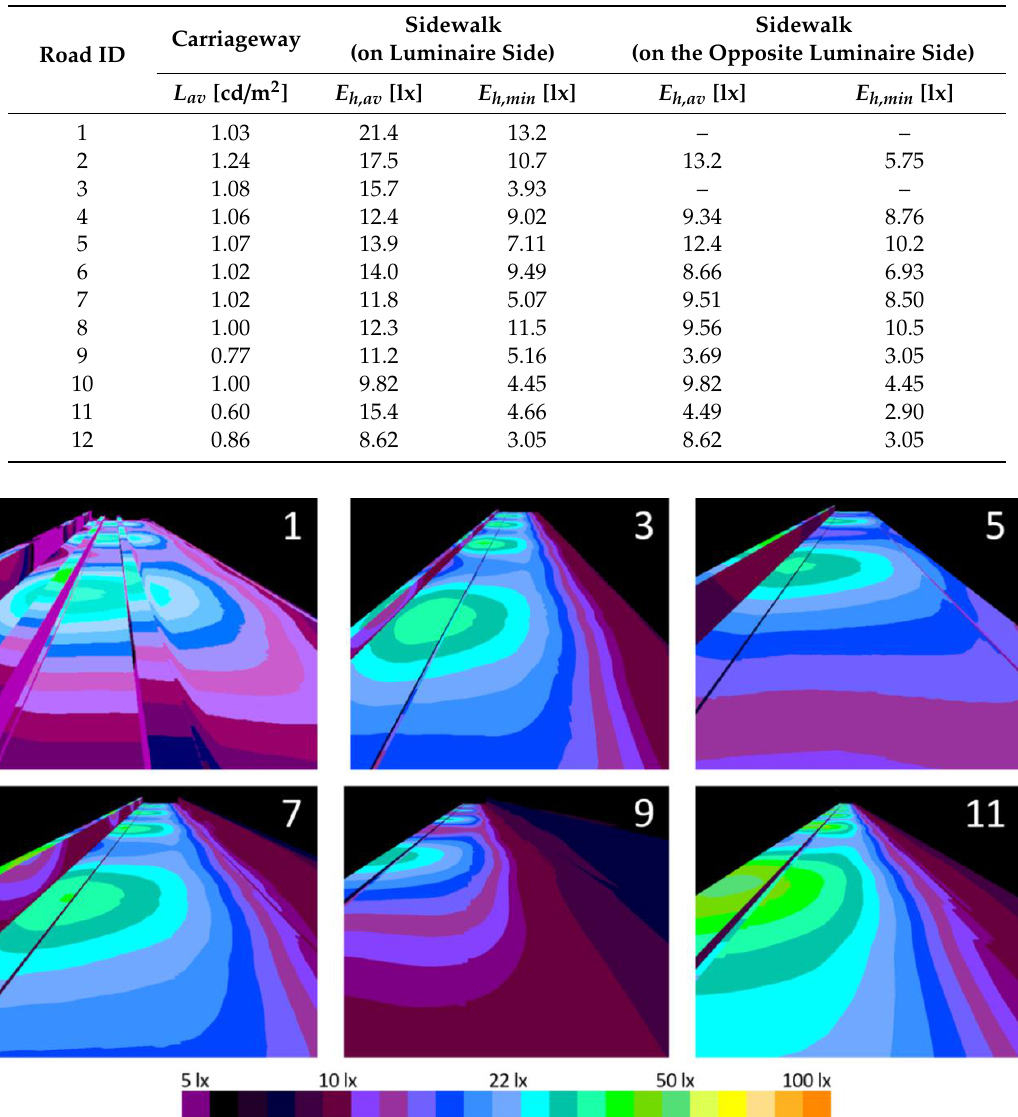
Table 10. Results of the software simulation at the design status for the considered lighting parameters. The luminance and illuminance values are expressed with three digits. Road ID